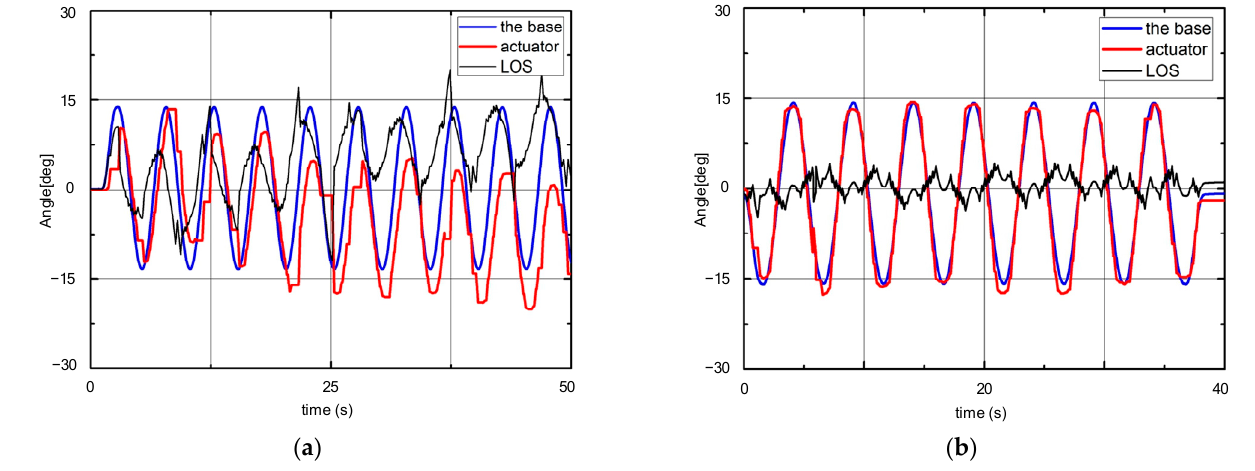
Figure 13. The contrast of the stability performance of the LOS: ( a ) the typical controller; ( b ) the proposed scheme.